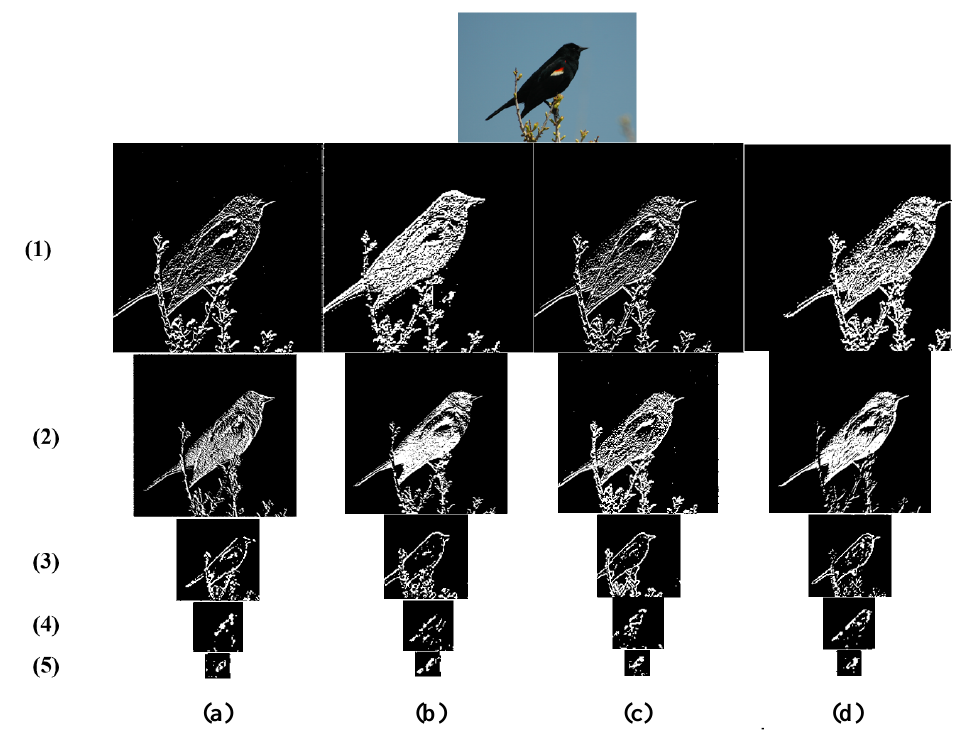
Figure 5. Visualization of MSBCNN based on the baseline VGG16 and VGG19. ( a ) BCNN-CUB200- VGG16, ( b ) MSBCNN -CUB200-VGG16, ( c ) BCNN-CUB200-VGG19, ( d )